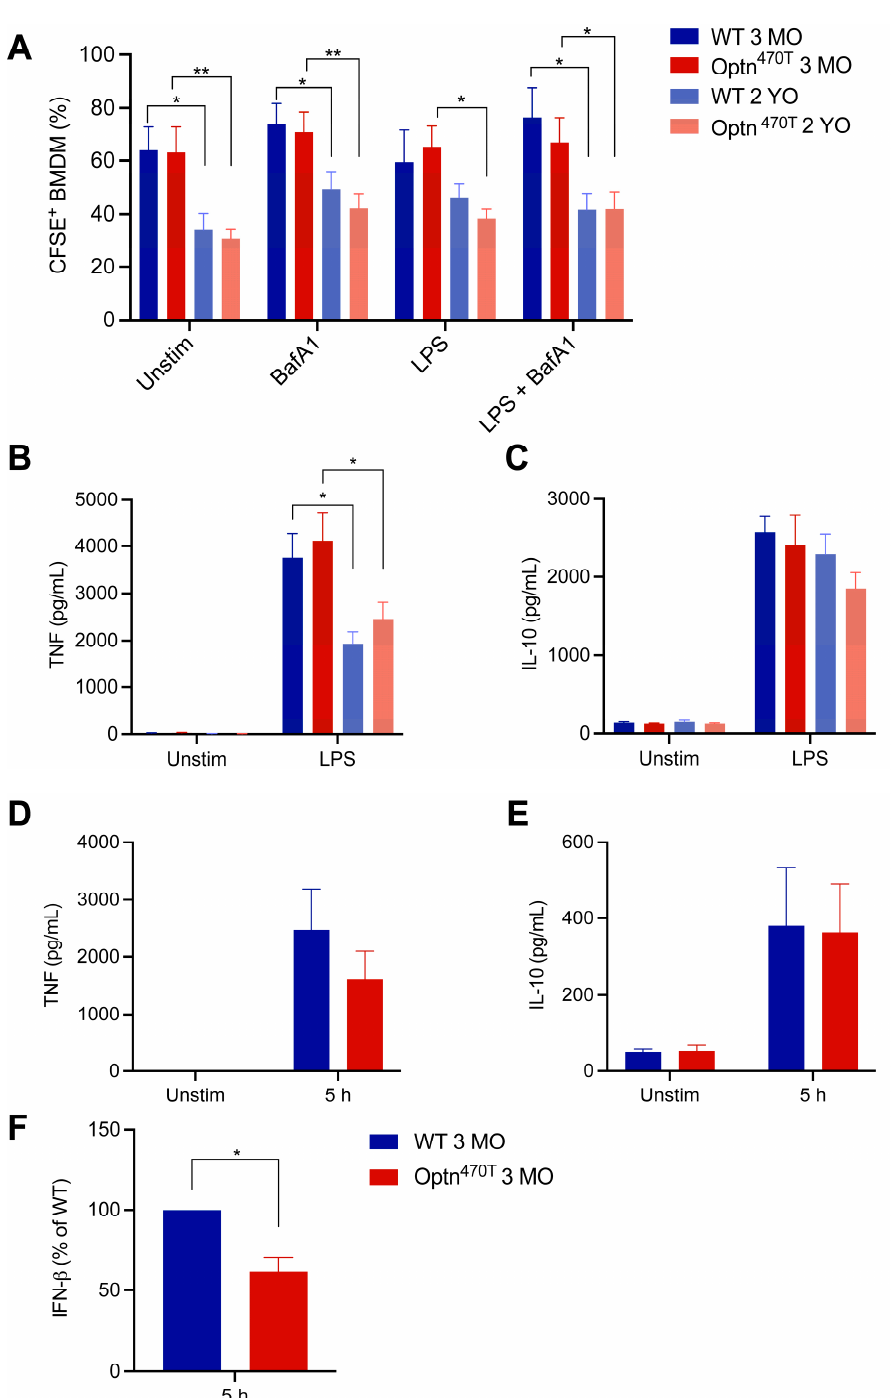
Figure 4. Ageing decreased the percentage of phagocytic BMDMs and pro-inflammatory cytokine secretion. ( A ) The percentage of phagocytic BMDMs from young (3-month-old; 3 MO) and aged mice (2-year-old; 2 YO), previously shown in Figures 2 and 3, were depicted in the same graph. Supernatants from unstimulated and LPS-pretreated cells were assayed by ELISA for ( B ) TNF- α and ( C ) IL-10. The data are shown as mean ± SEM from 4–6 independent experiments ELISAs for ( D ) TNF- α , ( E ) IL-10, and ( F ) IFN- β were performed on supernatants from phagocytosis assays with E. coli bioparticles collected at 5 h. The data are shown as mean ± SEM from three independent experiments. For IFN- β , the data were normalized to WT in each of the three individual experi- ments. Statistical analysis was done by unpaired Student’s t -test; * p < 0.05, ** p < 0.01.